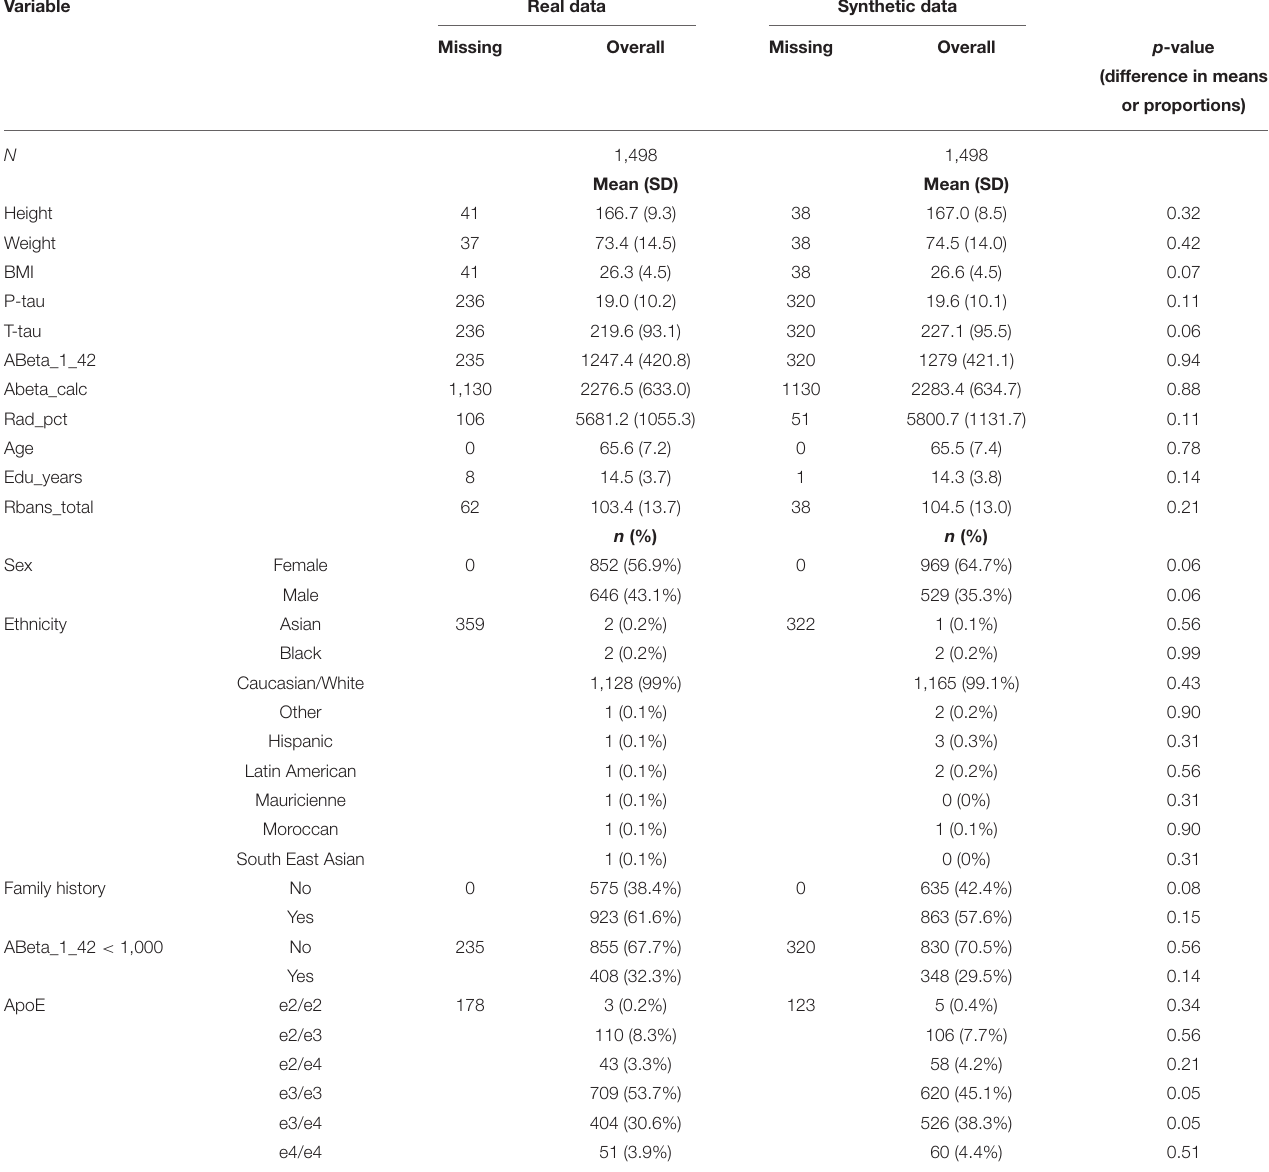
TABLE 1 | Descriptive statistics of the EPAD V1500 sample used and the synthetic data generated.